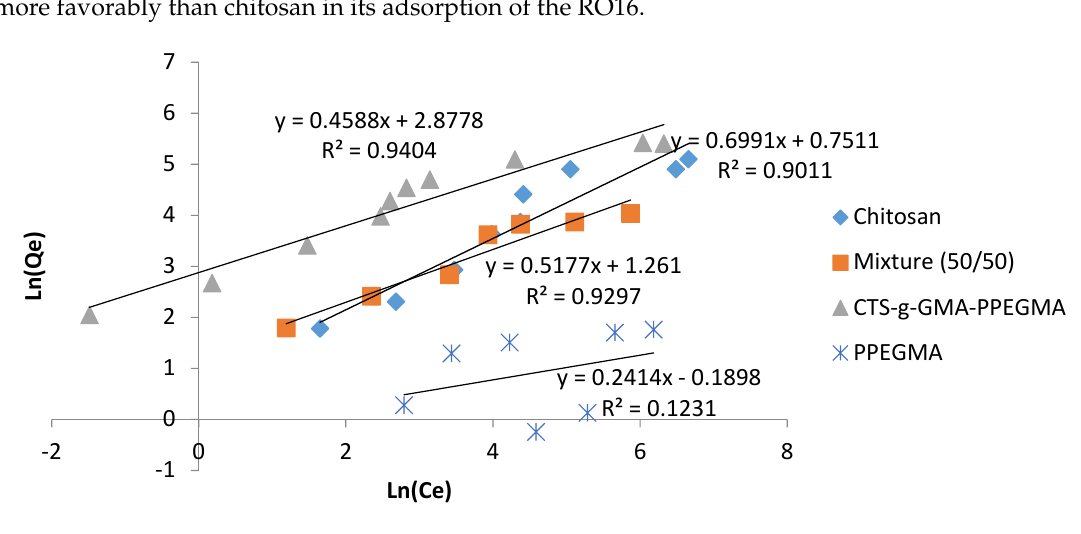
Figure 12. Adsorption % at different initial dye concentrations. 4. Conclusions Chitosan was functionalized with the vinyl monomer glycidyl methacrylate and then PPEGMA was grafted to the chitosan backbone. The PPEGMA was prepared by nitroxide ‐ mediated polymerization conducted in an aqueous system, giving a narrowly distributed polymer with